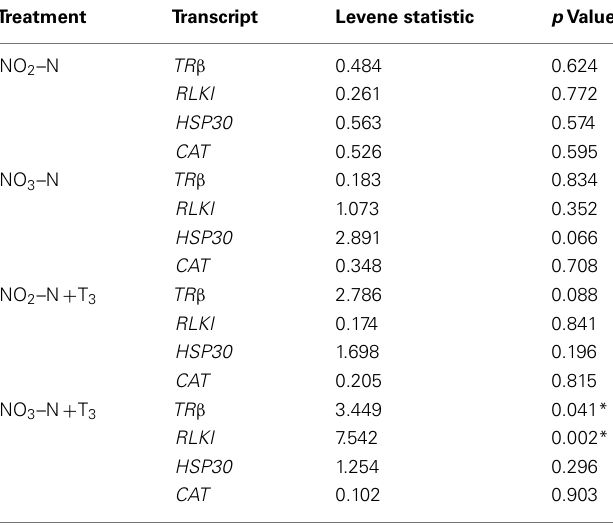
FIGURE 5 | QPCR analysis of heat shock protein 30 ( HSP30 ) and catalase ( CAT ) transcript levels in the C-fin assay after exposure to nitrate in the absence or presence of 10nMT 3 . Tail fin biopsies were exposed to vehicle control (water; 0) and the indicated test chemicals for 48h in the presence of 400nM NaOH or 10nMT 3 in 400nM NaOH solvent. Test chemical concentrations were 50mg/L sodium control (in the form of sodium gluconate, Na-G), 5 and 50mg/L NO 3 –N (in the form of NaNO 3 ).The results are expressed as fold change relative to the vehicle control (NaOH; upper panels) or to the vehicle + T 3 -induced levels (lower panels) and represent QPCR data from n = 16 animals. Increasing concentrations of test chemicals are represented by bevels. See Figure 1 legend for more details. Table 2 |Analysis of variation using Levine’s